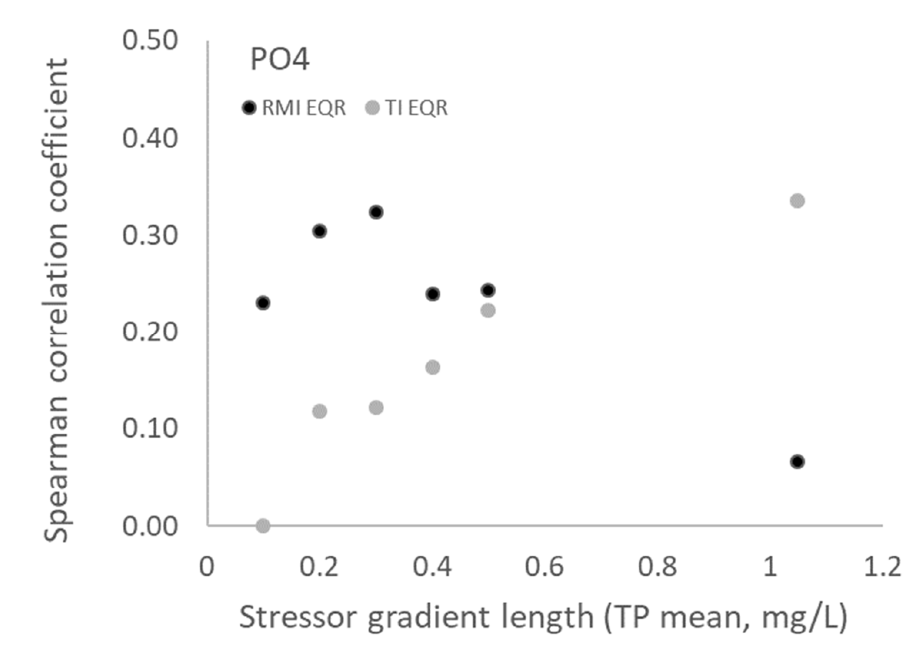
Figure 4. Changes in the correlation coefficient (R) between the orthophosphate—maximum value (PO4 max) and River Macrophyte Index (RMI EQR) and Trophic Index (TI EQR), respectively, as a function of the stressor gradient length expressed as the total phosphorous—annual mean value (TP mean).